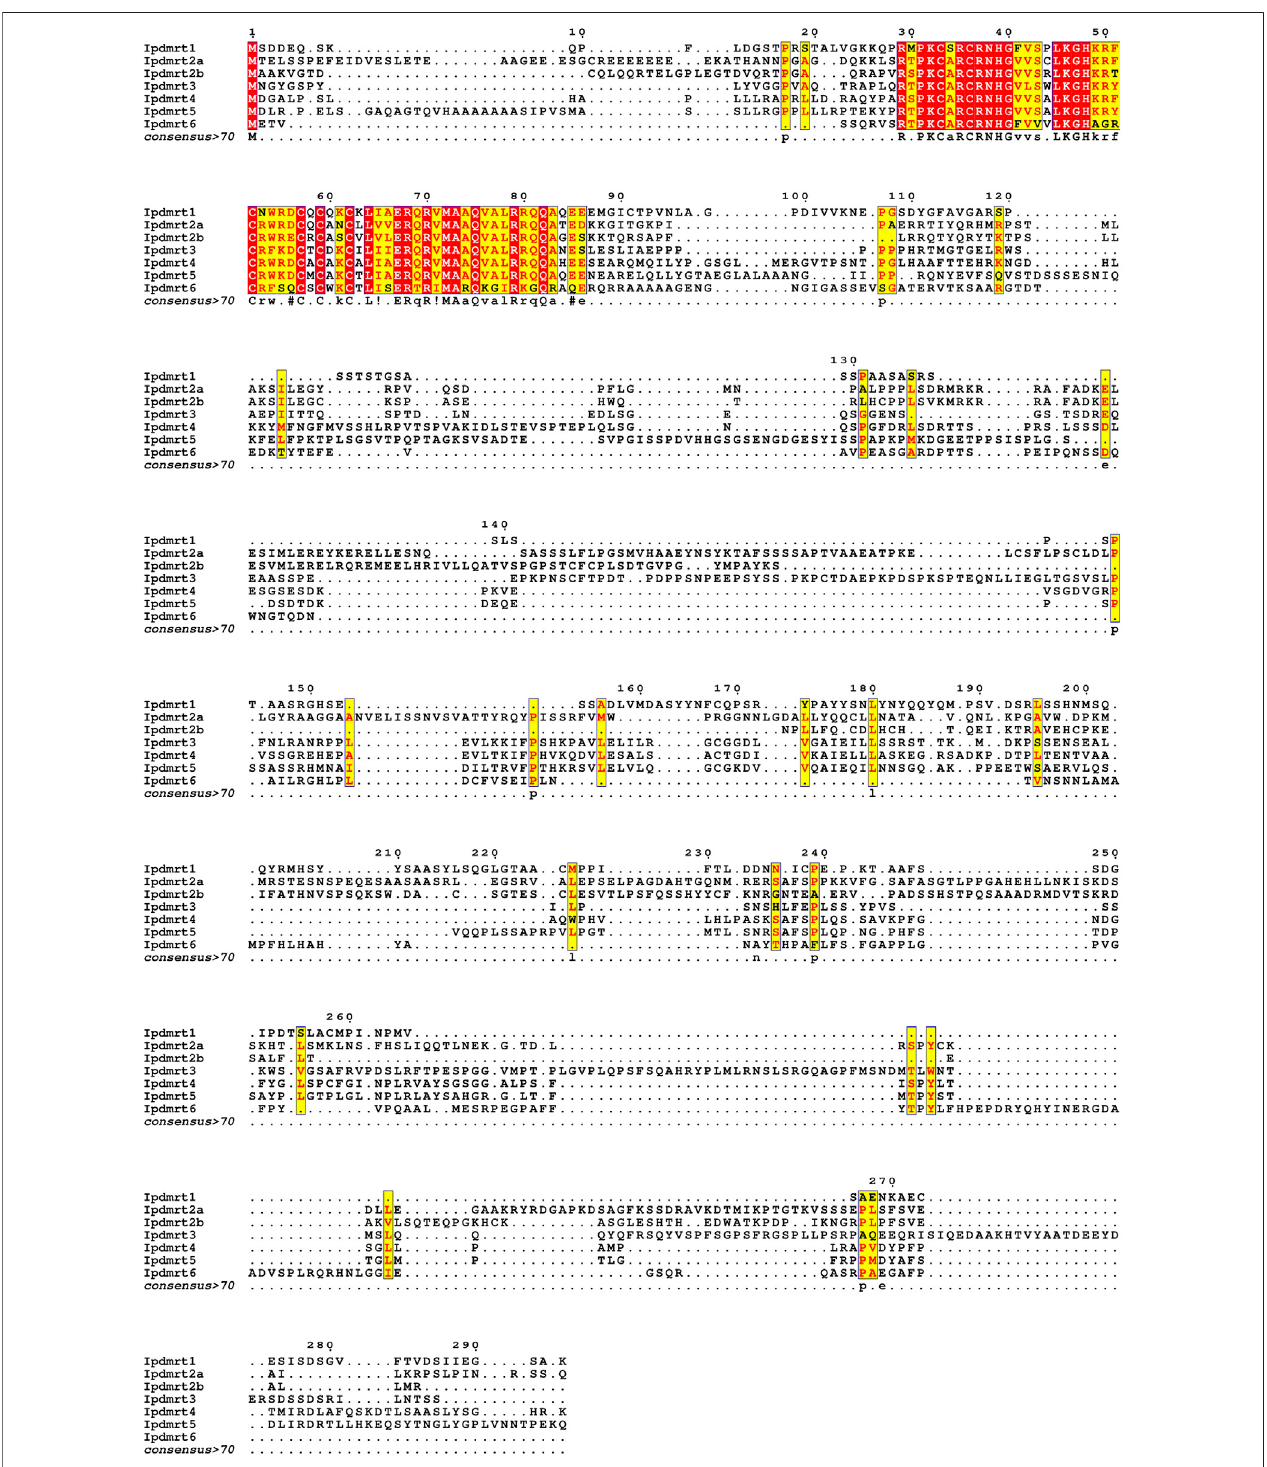
FIGURE2| Multiple sequence alignments ofDmrtproteins. Thealignmentswereperformedusingthe T-COFFEE onlinesoftware,andwerevisualized inEsPriptv. 3.0(availableonline).ThepartialproteinsequenceintheredboxrepresentstheDMdomain,whichhasahigherconservation,whiletheproteinsequenceoutsideithasa lower level of